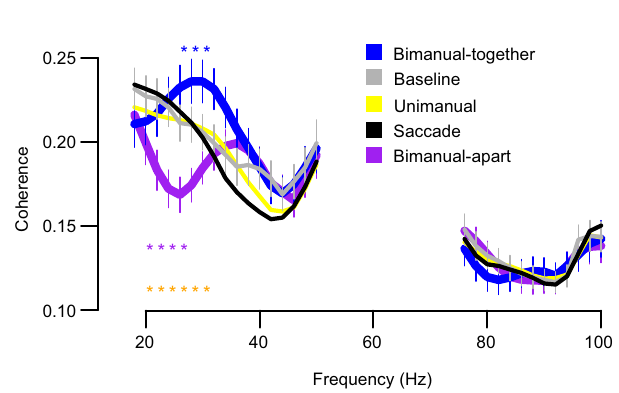
Fig. 2 Beta-band LFP – LFP coherence between PRR in the left and right hemispheres distinguishes bimanual-together and bimanual-apart movements from baseline and from unimanual movements. Coherence in the beta band (~20 – 30 Hz) is elevated for bimanual-together movements (blue) and decreased for bimanual-apart movements (purple) compared to unimanual reaches (yellow) or to the baseline period (gray). Coherence during saccade trials (black) resembled that seen during unimanual reach. Data are averaged from the 113 pairs of sites (43 from MkT, 70 from MkZ) recorded simultaneously in the two hemispheres, with coherence measured in the − 500 – 0 ms interval before the cue to move. Blue and purple asterisks indicate signi fi cant differences of bimanual-together and bimanual-apart, respectively, versus unimanual. Gold asterisks denote comparison of bimanual-together versus bimanual-apart (two-sided t-tests, large asterisks = P < 0.05 after Bonferroni correction for testing at each of the 39 different frequency values plotted in the fi gure). Coherence outside the pictured range (from 16 to 20 Hz and 100 to 240 Hz) was unaffected (corrected P > 0.05). Error bars = ±1 s.e.m. Source data are provided as a Source Data fi